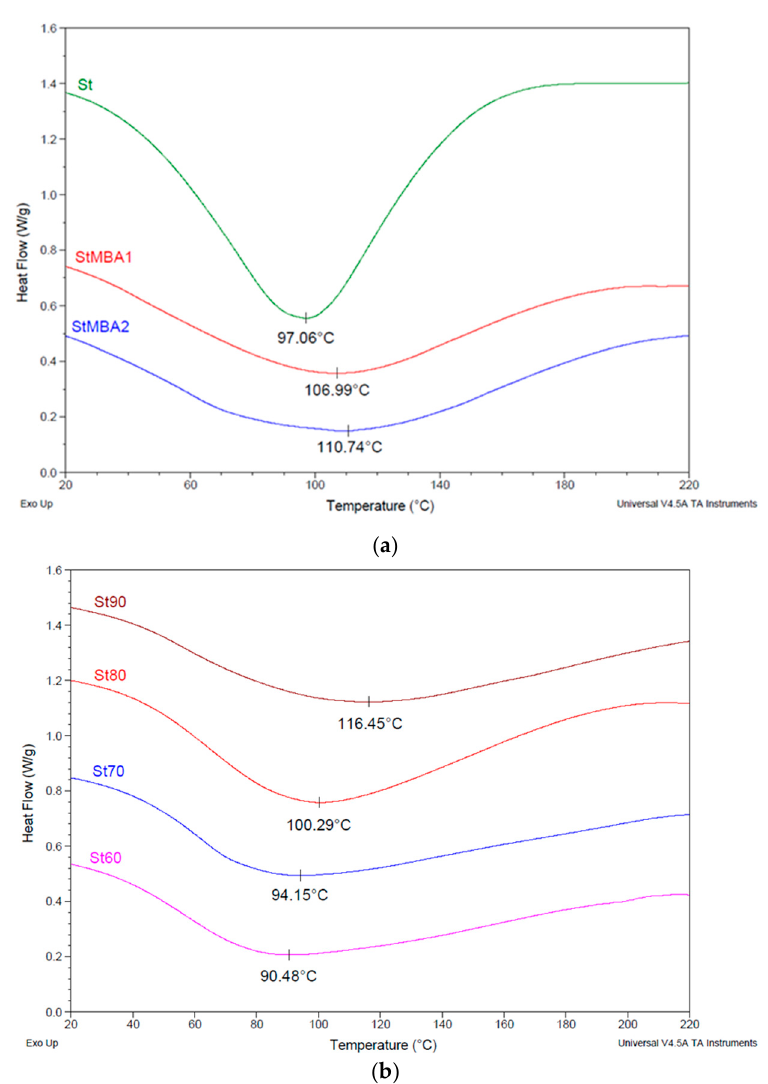
Figure 4. Differential scanning calorimetry: ( a ) of native potato starch (St) and cross-linked starches (StMBA1 and StMBA2); ( b ) cross-linked starch-g-polyacrylamide absorbents with different amount of natural polymer St90, St80, St70 and St60.